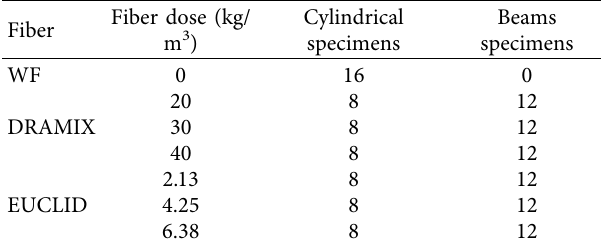
Table 5: Summary of tested